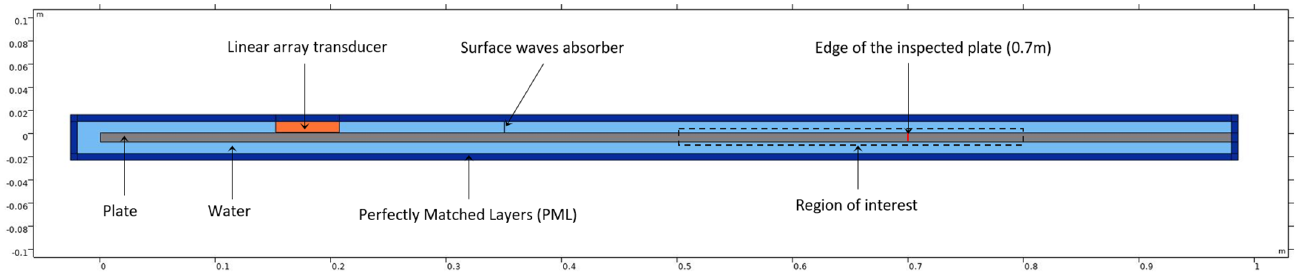
Figure 7. Sketch of the simulation under COMSOL Multiphysics ® .